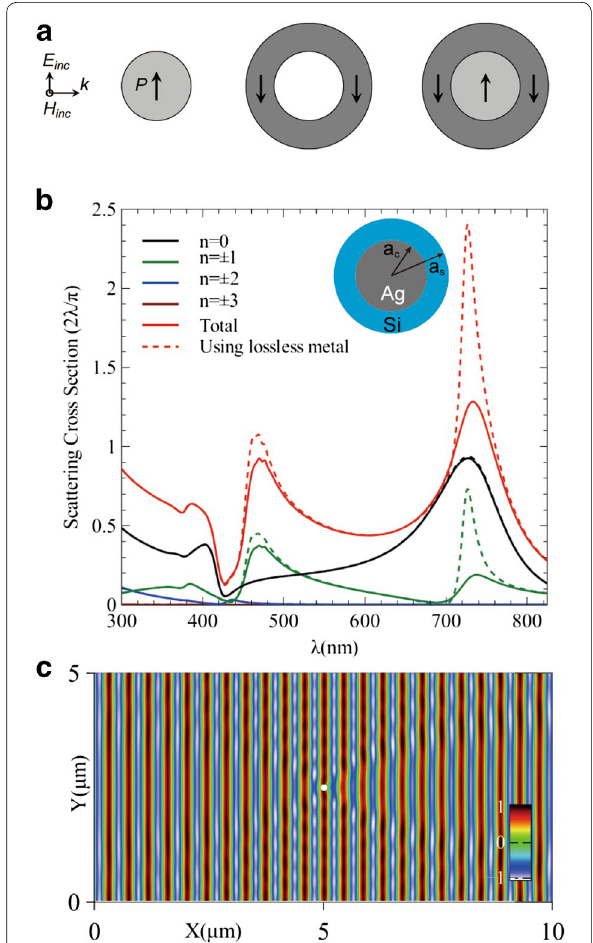
Fig. 1 Invisibility cloaking of a metal/semiconductor core/shell plasmonic NW. a Qualitative description of plasmonic cloaking in the quasi‑static approximation. In a rationally designed core/shell NW, the local polarization vectors of the shell and the core can be anti‑parallel (left and middle) and thus cancel each other (right). b Total scattering cross‑section spectrum (red solid line) of a core/shell NW (Ag core radius a c 18 nm and Si shell radius a s 73 nm) for TE‑polarized = = light and scattering contributions of individual angular modes. The invisible wavelength was determined at the wavelength of 427 nm where the total scattering cross‑section shows a dip and the scatter‑ ing contribution from each angular mode is minimized. c Near‑field distribution around the core/shell NW (denoted by a white circle) at the invisible wavelength of 427 nm ( a is adapted from [24], and b , c are adapted from